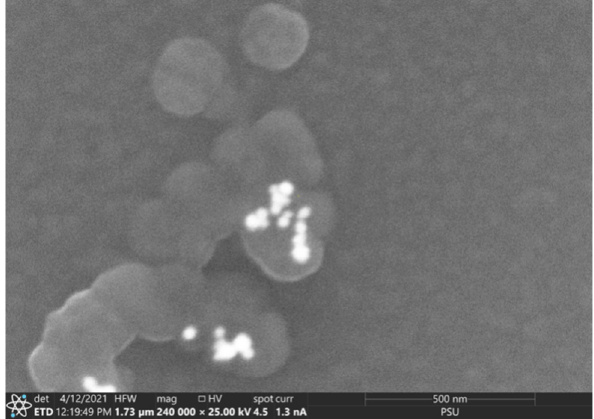
Figure 8. SEM images ( a ) and elemental spectra ( b ) of AuNPs synthesized by R. erythropolis IEGM